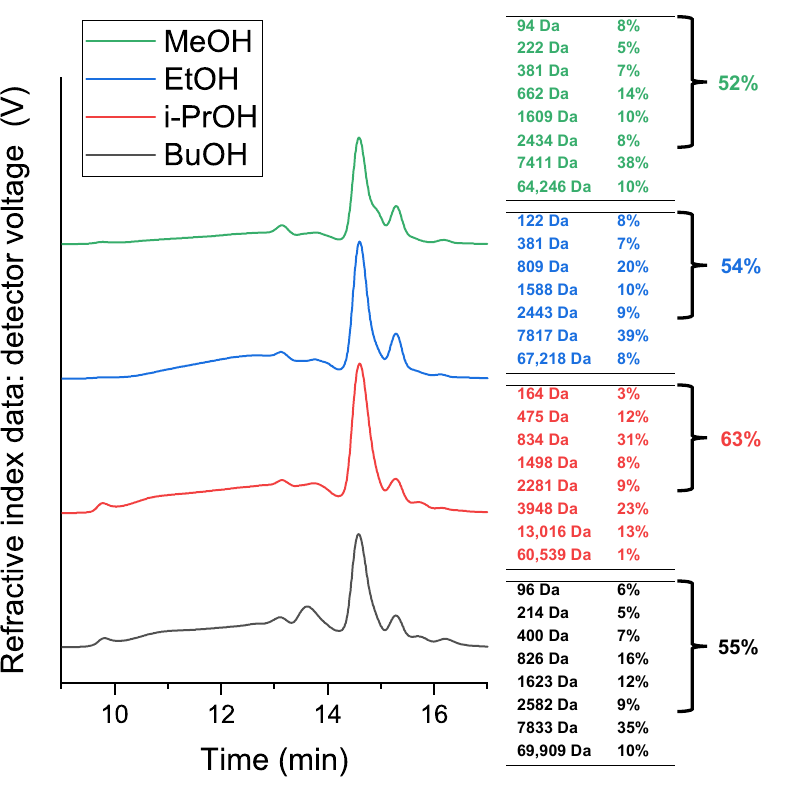
Figure 1. SA-based adhesive sample SEC-RID chromatograms.